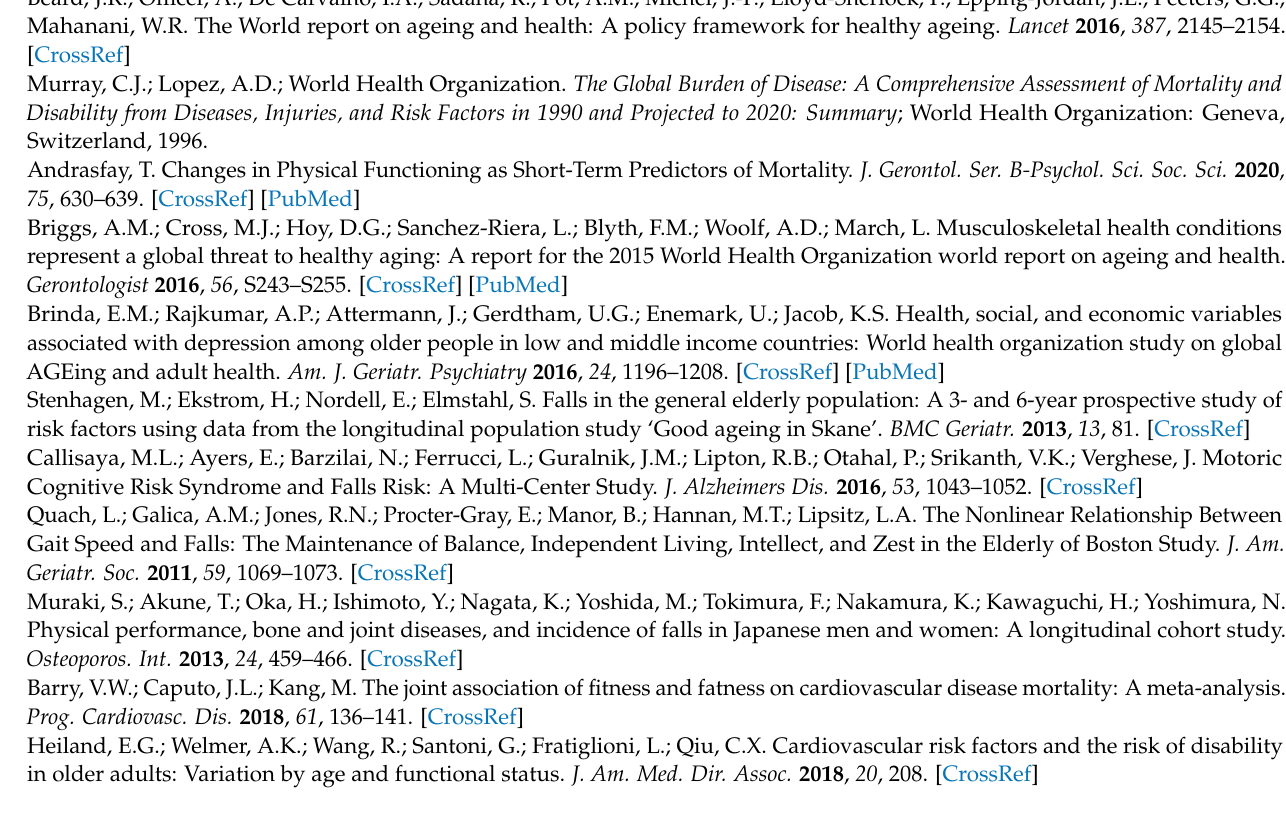
Figure S2: Cut-off points of gait speed at usual pace and risk of adverse outcomes found in the selected studies and systematic reviews/meta-analysis; Figure S3: Cut-off points of timed up&go test and risk of adverse outcomes found in the selected studies and systematic